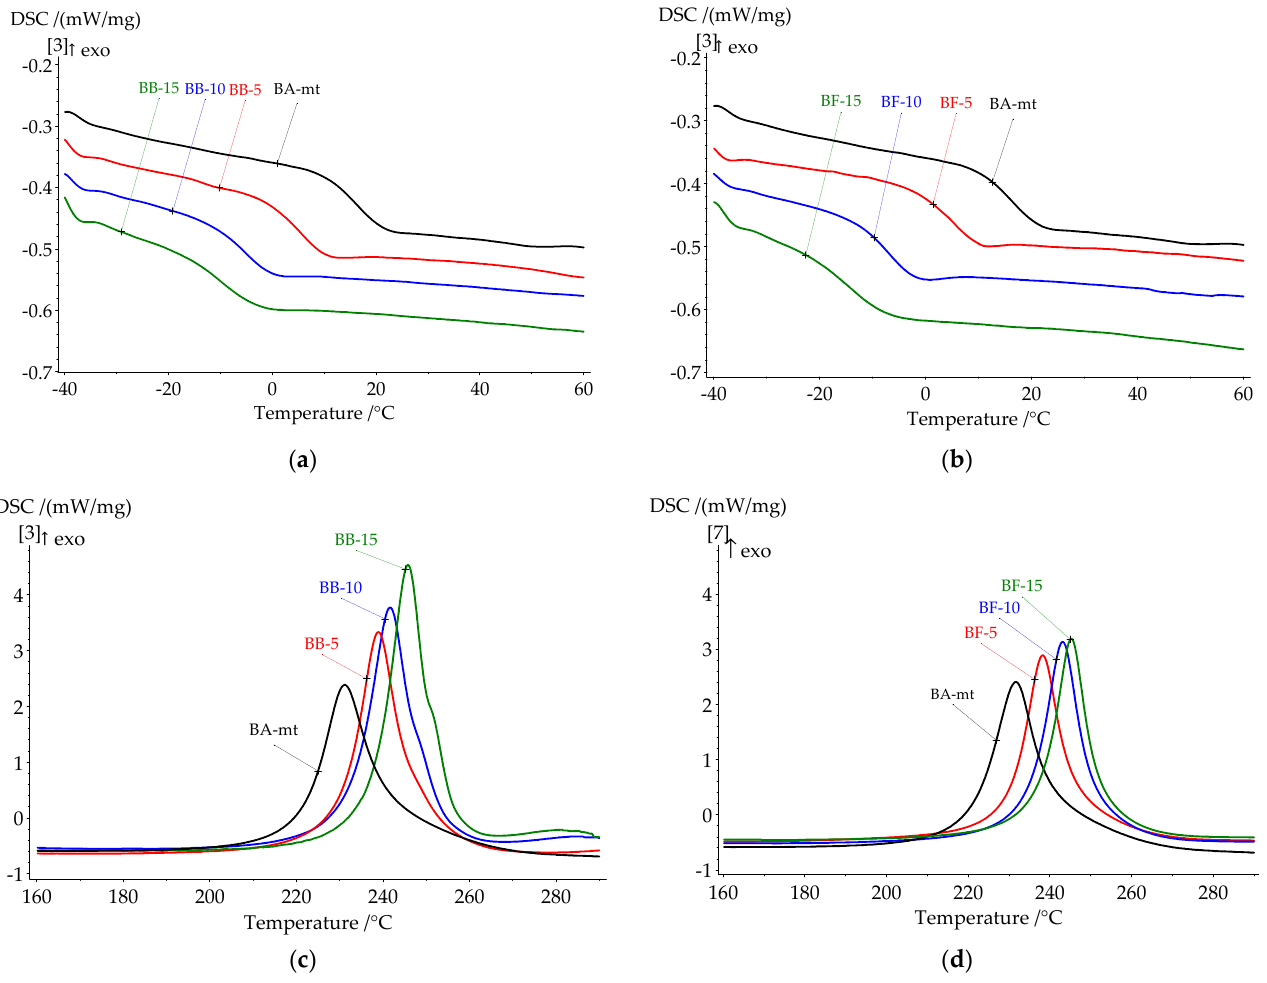
Figure 3. DSC curves of glass transitions of uncured blends with BD ( a ) and with FUR ( b ) and exothermic peaks of curing for blends with BD ( c ) and FUR ( d ). Table 2. Characteristic temperatures and enthalpy values for the curing process and glass tempera- tures for uncured and cured specimens.